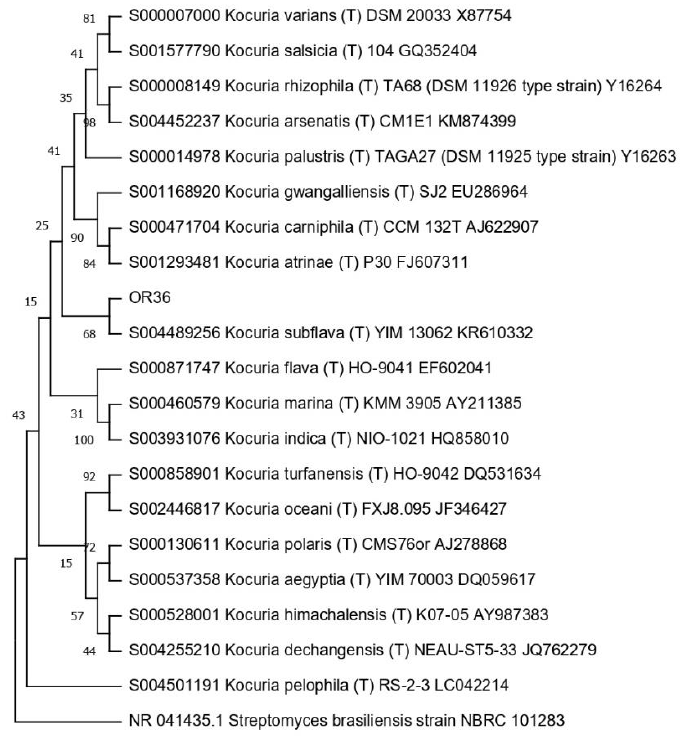
Figure 5. Phylogenetic tree for the genus Kocuria.